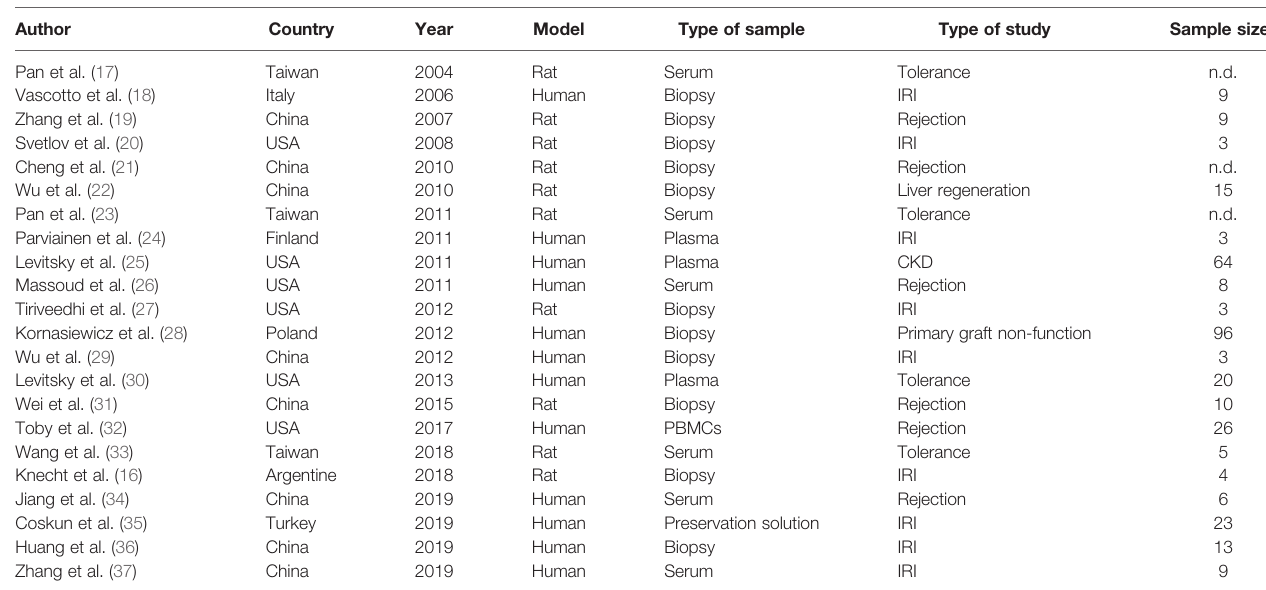
TABLE 1 | Principal characteristics of the publications selected for this